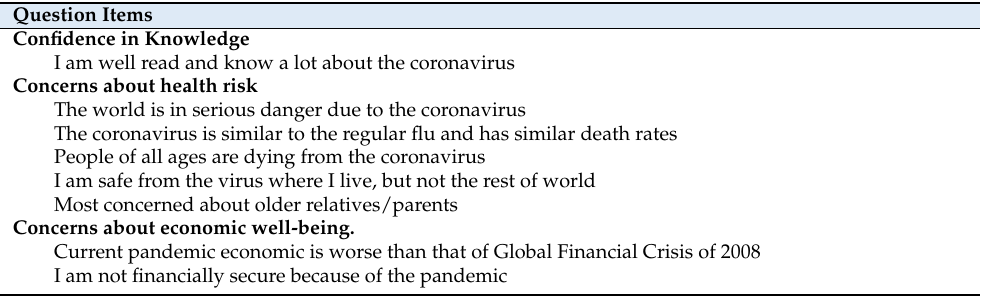
Table 1. Questions for risk perception of the COVID-19 pandemic. Question Items Confidence in